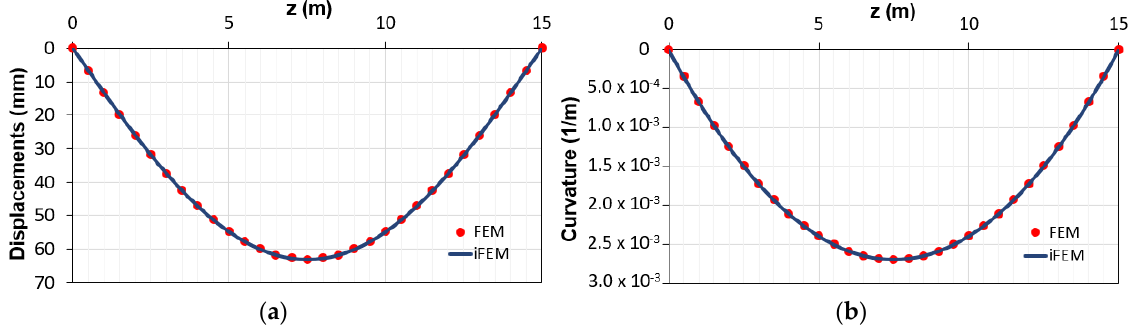
Figure 5. Comparison between direct finite element method (FEM) and inverse finite element method (iFEM) solutions in terms of ( a ) displacements diagram; ( b ) curvature diagrams.